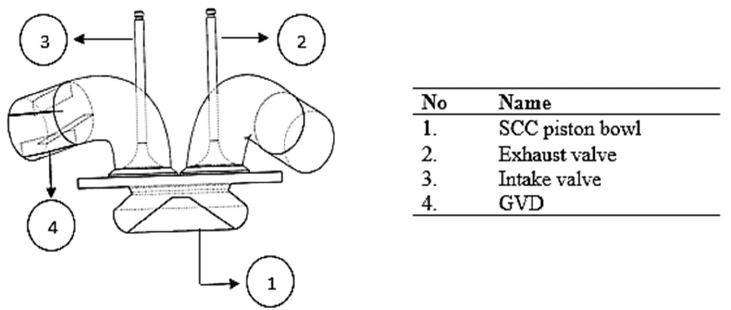
Table 2. Specifications of the installed (GVD).